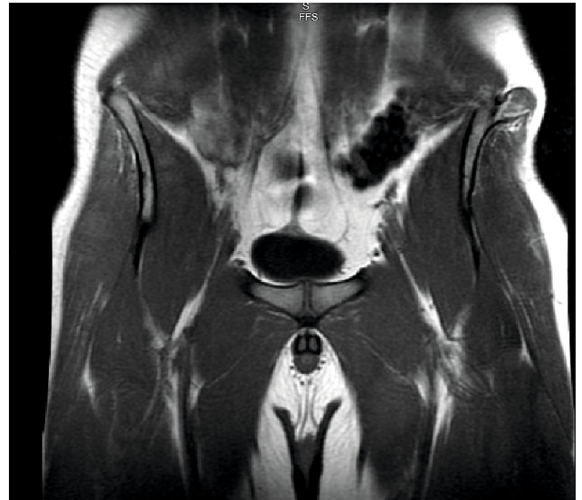
Figure 3: Intraoperative photograph of anterior left pelvis. The photograph demonstrates a pedunculated exophytic mass growing from the left iliac wing. The mass is super fi cially covered by a cartilaginous cap which can be appreciated surrounding the cortical bone (Osteochondroma Intra operative Left anterior hip.jpg).